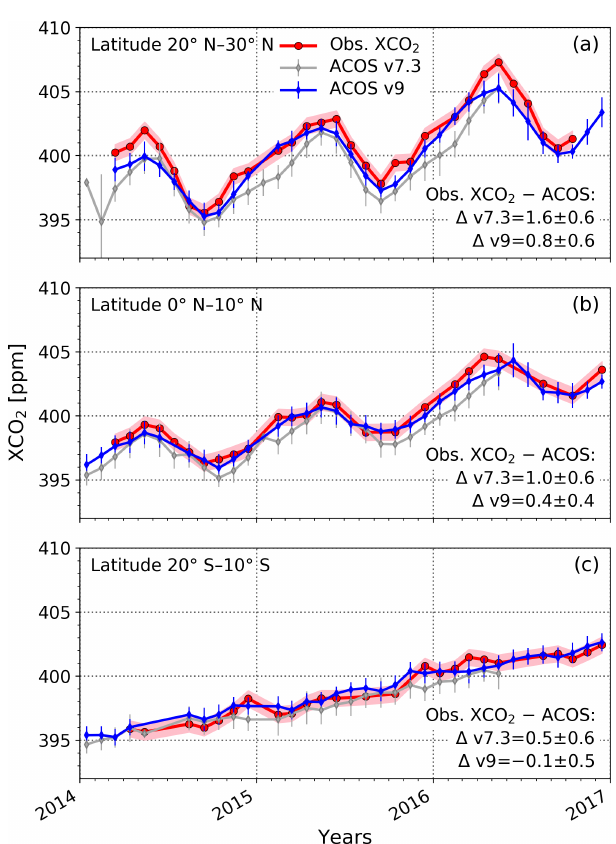
Figure A1. Comparison of the temporal variation of obs. XCO 2 (red) with XCO 2 derived from ACOS v7.3 (gray) and ACOS v9 (blue) for three selected latitude ranges. Red-shaded areas are the uncertainty of the obs. XCO 2 which was derived from the ± 2ppm variability in the observation-based CO 2 profile at ∼ 850hPa. Error bars show the standard deviation of the monthly averaged XCO 2 .